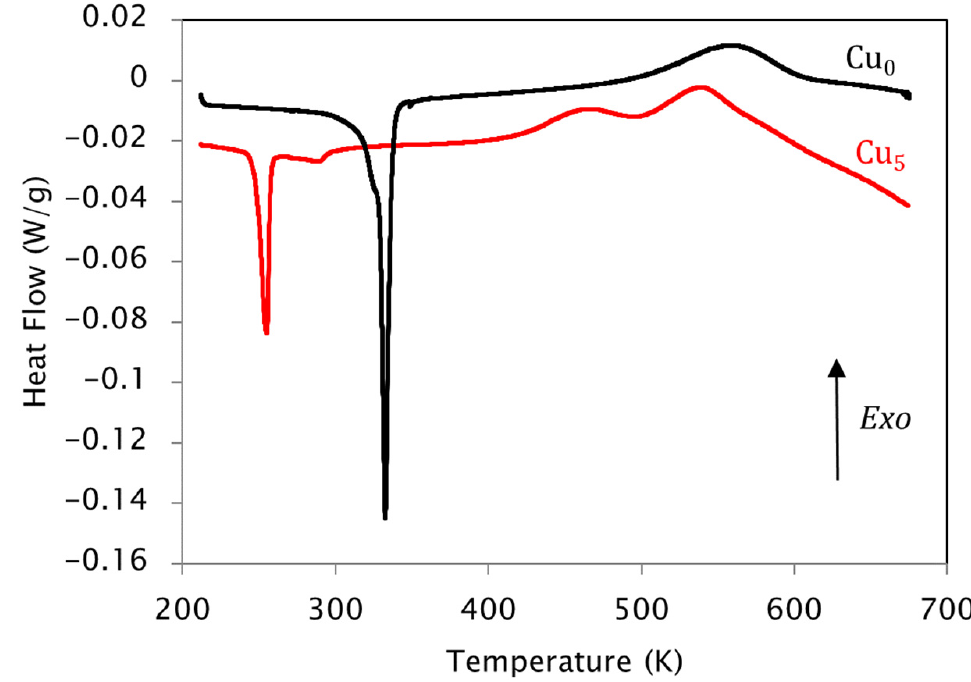
Figure 3. DSC curves obtained during heating up to 670 K of Cu 5 and ternary Cu 0 samples previously quenched from 1020 K. Adapted from [22].